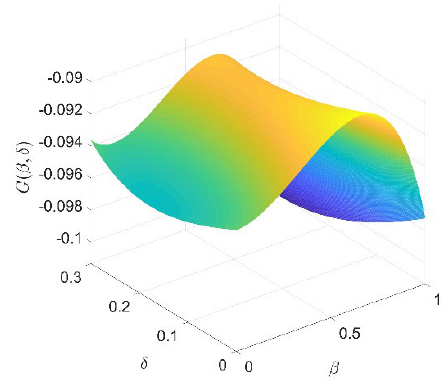
Figure A1. G ( β , δ ) with respect to β and δ Figure A1.